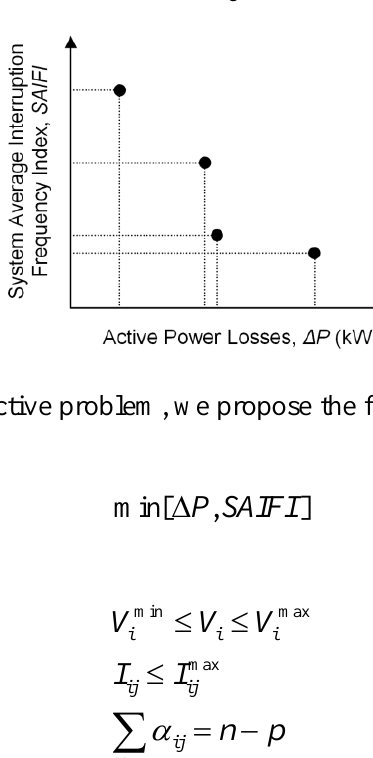
Figure 2. A Pareto front for a bi-objective reconfiguration